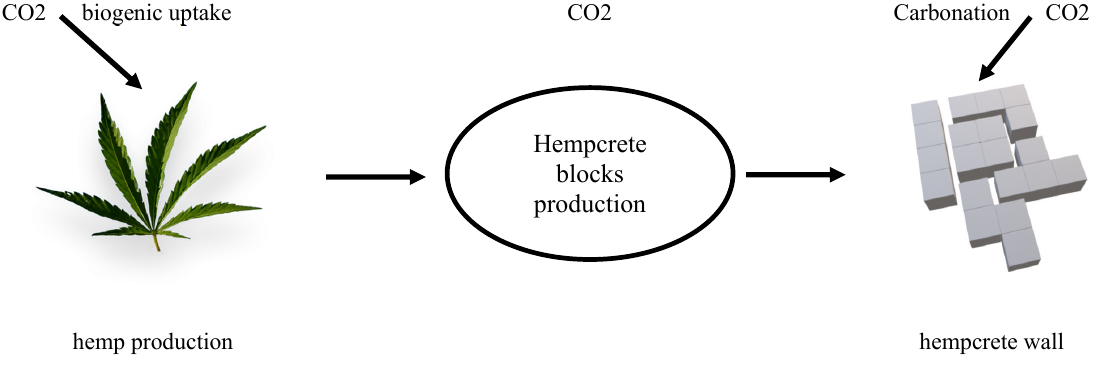
Graph 6. Graphic carbonation process. Note. The graph represents how both the plant and the brick comply with the CO2 purification process. Taken from Bio-Brick - Development of Sustainable and Cost Effective Building Material. (p. 3176), by Rautray et al,